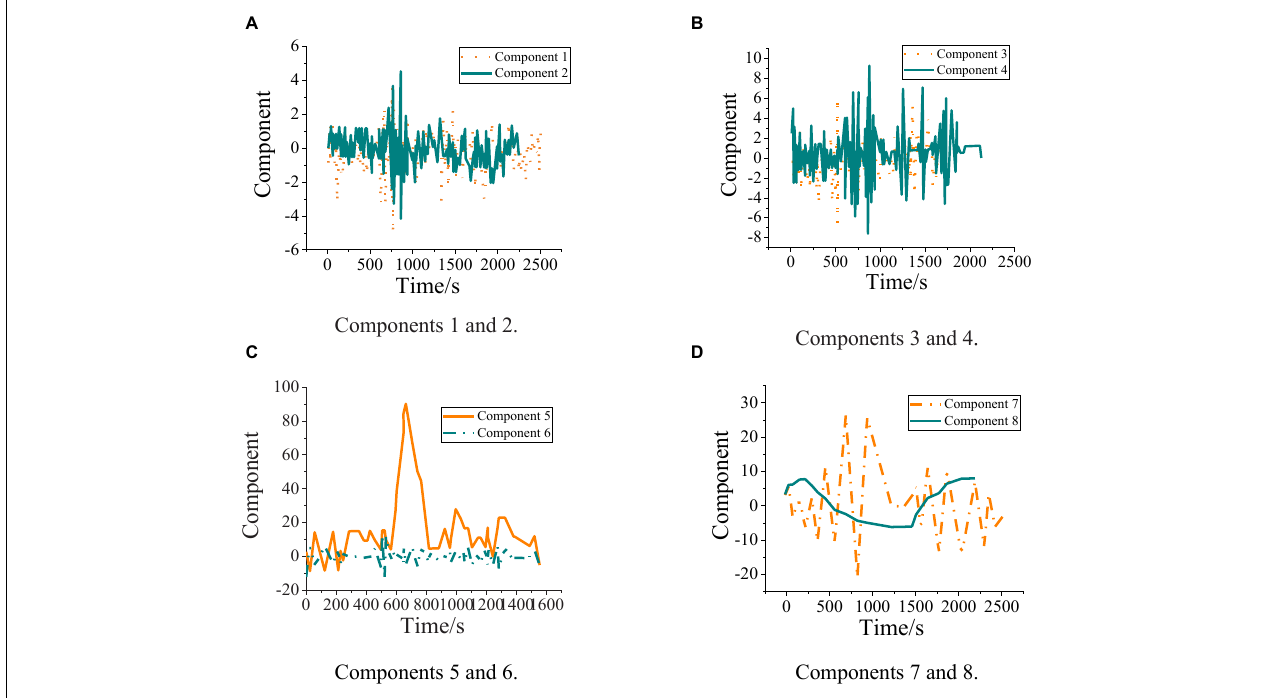
FIGURE 5 | Time-domain diagram of each natural mode component. (A) Components 1 and 2. (B) Components 3 and 4. (C) Components 5 and 6. (D) Components 7 and 8.